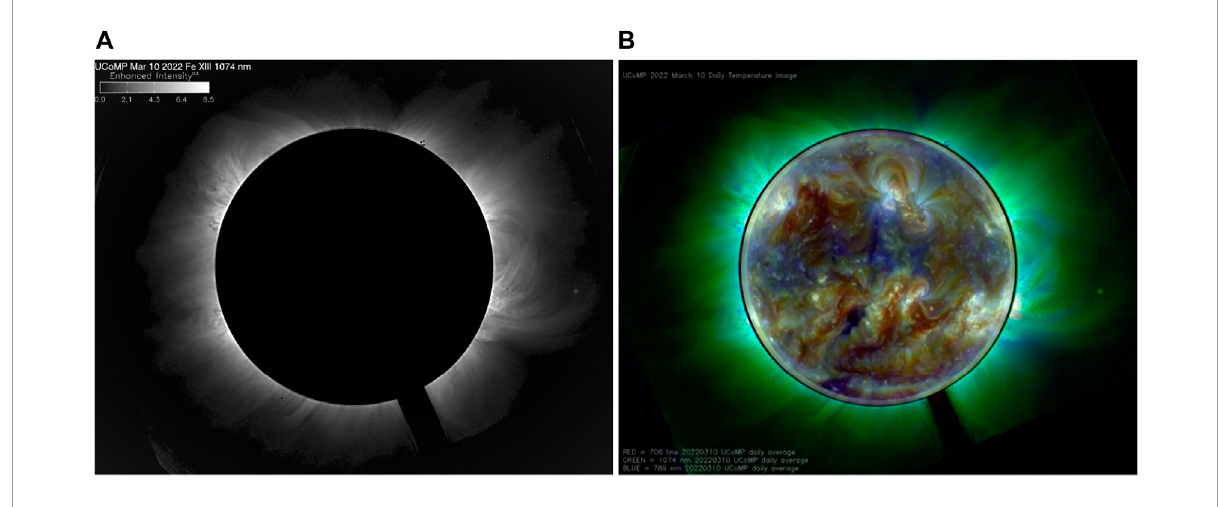
FIGURE 4 Example of UCoMP observations. (A) : enhanced intensity image of the solar corona with the Fe XIII 1074 nm line, taken on 10 March 2022. (B) : UCOMP daily temperature map obtained with the superposition of daily average images of Fe XV 706 nm (red), Fe XIII 1074 nm (green) and 789 nm (blue) of the solar corona; on the disk, an SDO/AIA multi-channel image has been